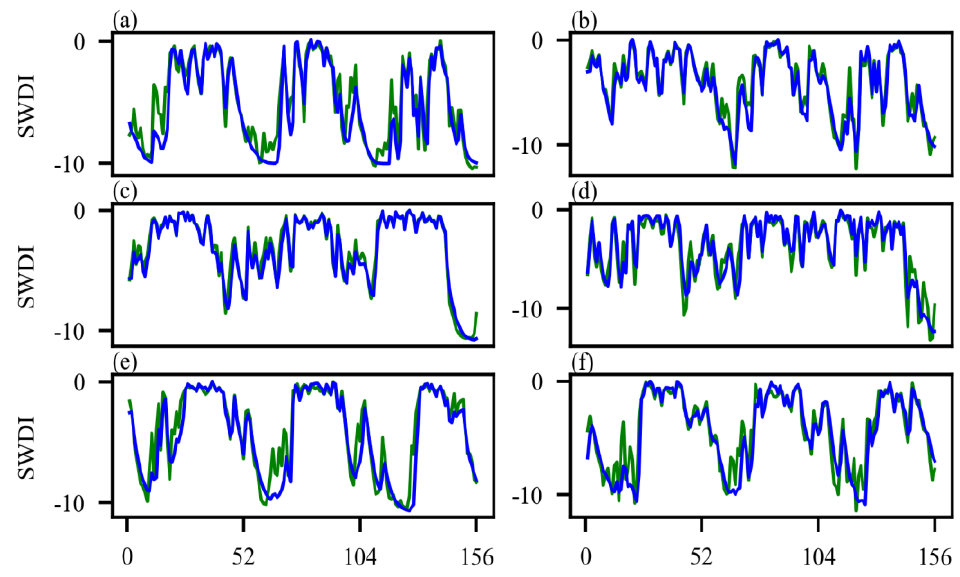
Figure 7. Weekly SWDI index in the surface (solid green line) and subsurface (solid blue line) layers at Dongfang ( a ), Qionghai ( b ), Fogang ( c ), Nanning ( d ), Lincang ( e ), and Yanshan ( f ) sites.